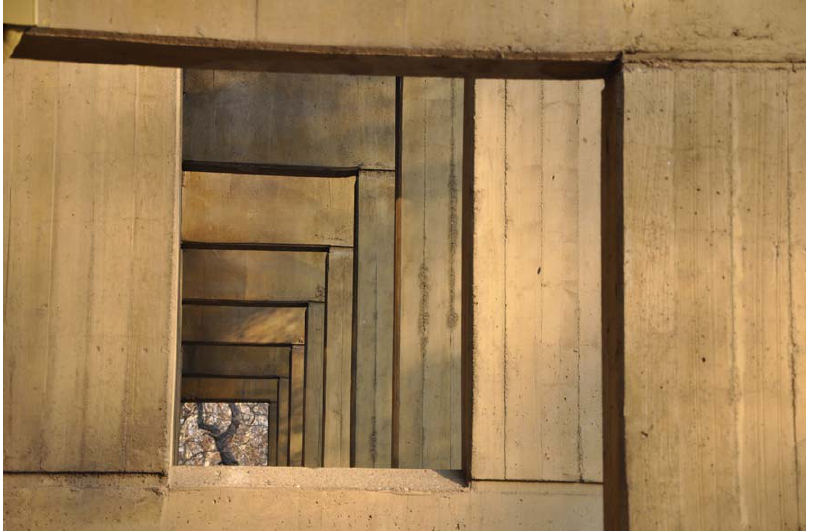
to provide non-experts with insight into the significance of the published